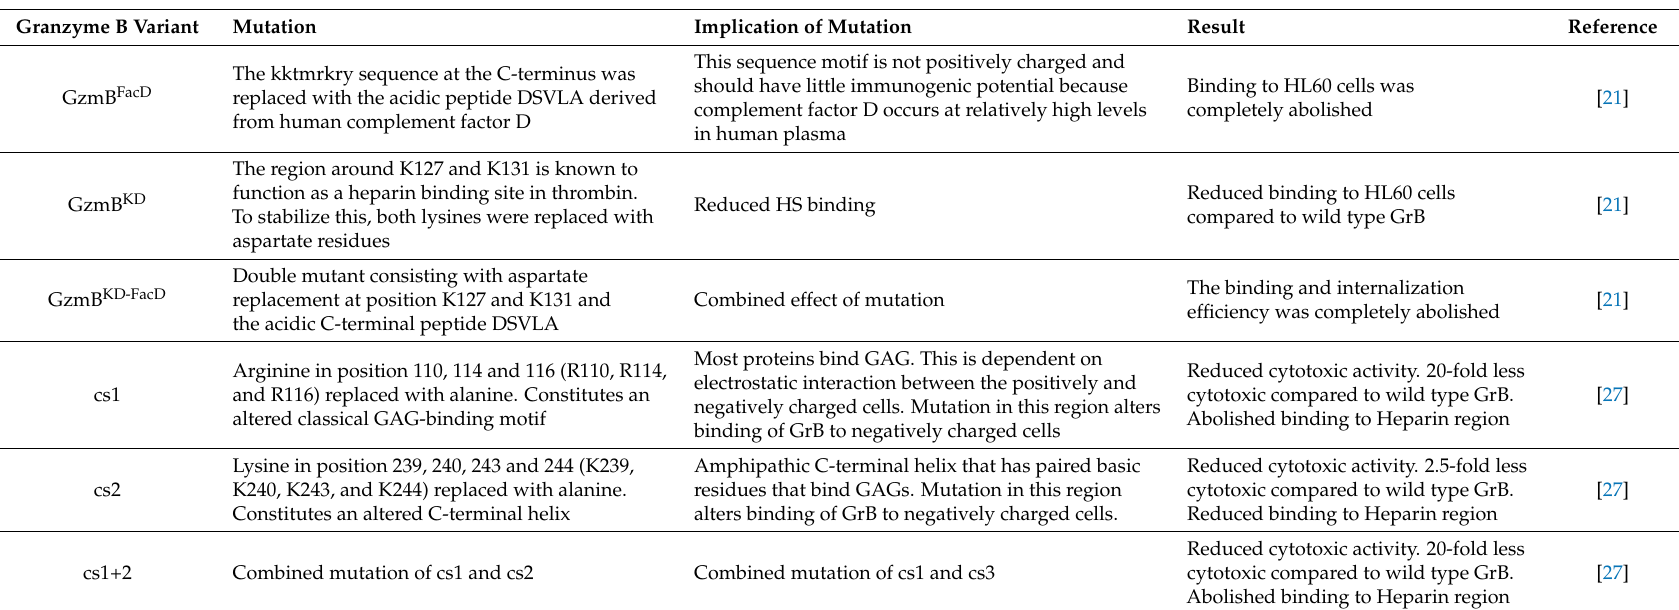
Table 2. Granzyme B mutants for improved specific binding and reduced off-target